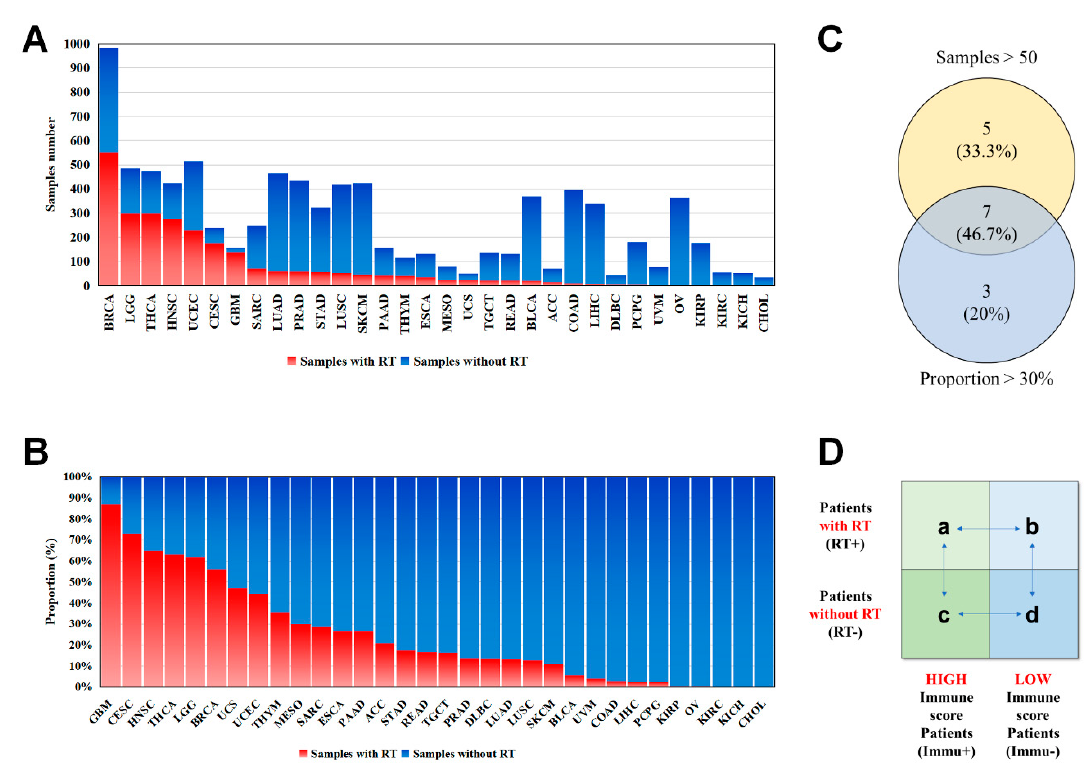
Figure 1. Overview of the samples downloaded from TCGA. ( A ) Number of samples for each cancer type were shown, sorted by the number of samples receiving radiation therapy. ( B ) The percent adoption of RT in different cancers. The red and green represent the patients with or without RT, respectively. ( C ) Cancers with a total sample size greater than 50 and a RT application rate greater than 30% were selected for subsequent analysis. ( D ) According to the immune infiltration level and RT status, the patients with each cancer were divided into four different subgroups. Immune Score was calculated by ESTIMATE algorithm. Take subgroup ( a ) as an example, these patients received RT and their tumors had a high level of immune infiltration. In the subsequent analysis, we compared the survival di ff erences between di ff erent subgroups, they are: ( a + b ) vs. ( c + d ), ( a ) vs. ( b ), ( a ) vs. ( c ), ( b ) vs. ( d ), ( c ) vs. ( d ), respectively.